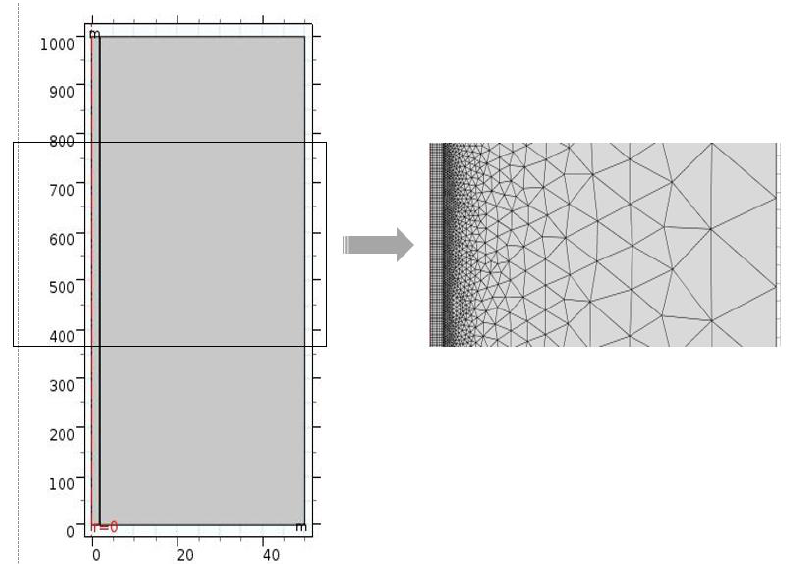
Figure 6. The physical model and partial grid partition.